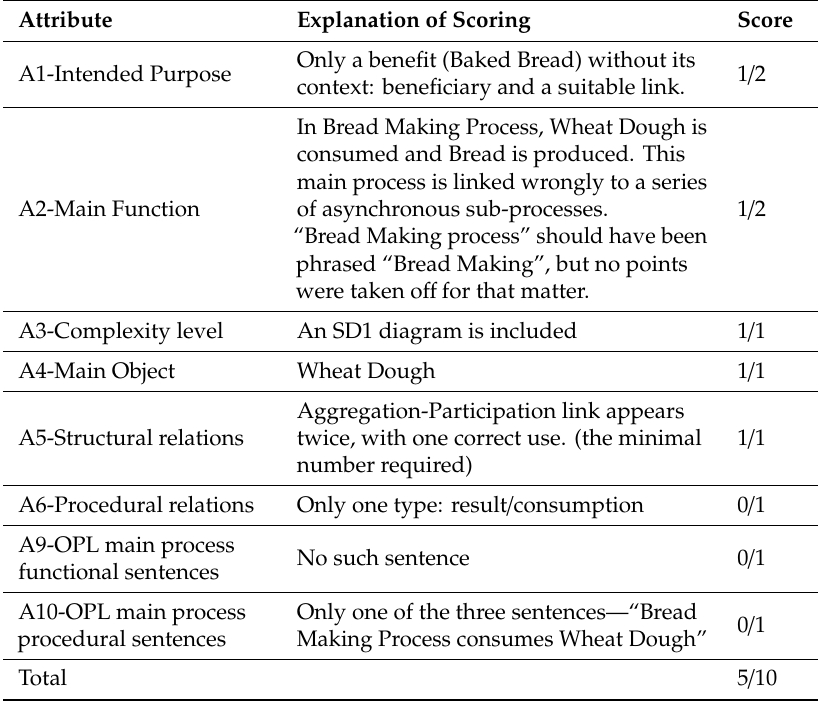
Table 8. Explanation of participant # 112122201 modeling